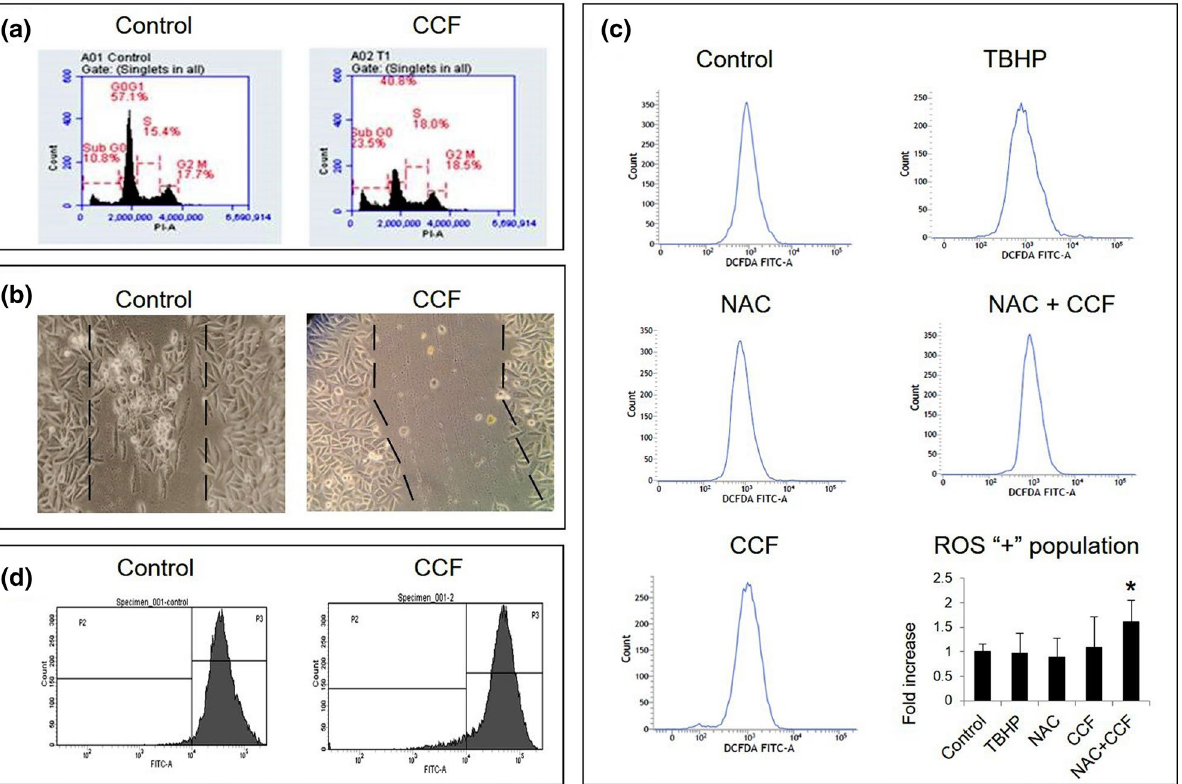
Figure 2. Cytotoxicity induced by CCF in SiHa cells, ( a ) Flow Cytometric analysis of Cell Cycle kinetics; ( b ) Effect of CCF on wound healing capabilities; ( c ) Flow Cytometric analysis of DCFDA stained cells for detection of intracellular ROS generation, Bar graph showing fold increase accumulation of intracellular ROS in cells, Values are expressed as mean ± SD of three independent experiments (n = 3), *denotes significant difference between control and treated sets ( P < 0.05); ( d ) Flow Cytometric analysis of loss of mitochondrial membrane potential by Rh 123